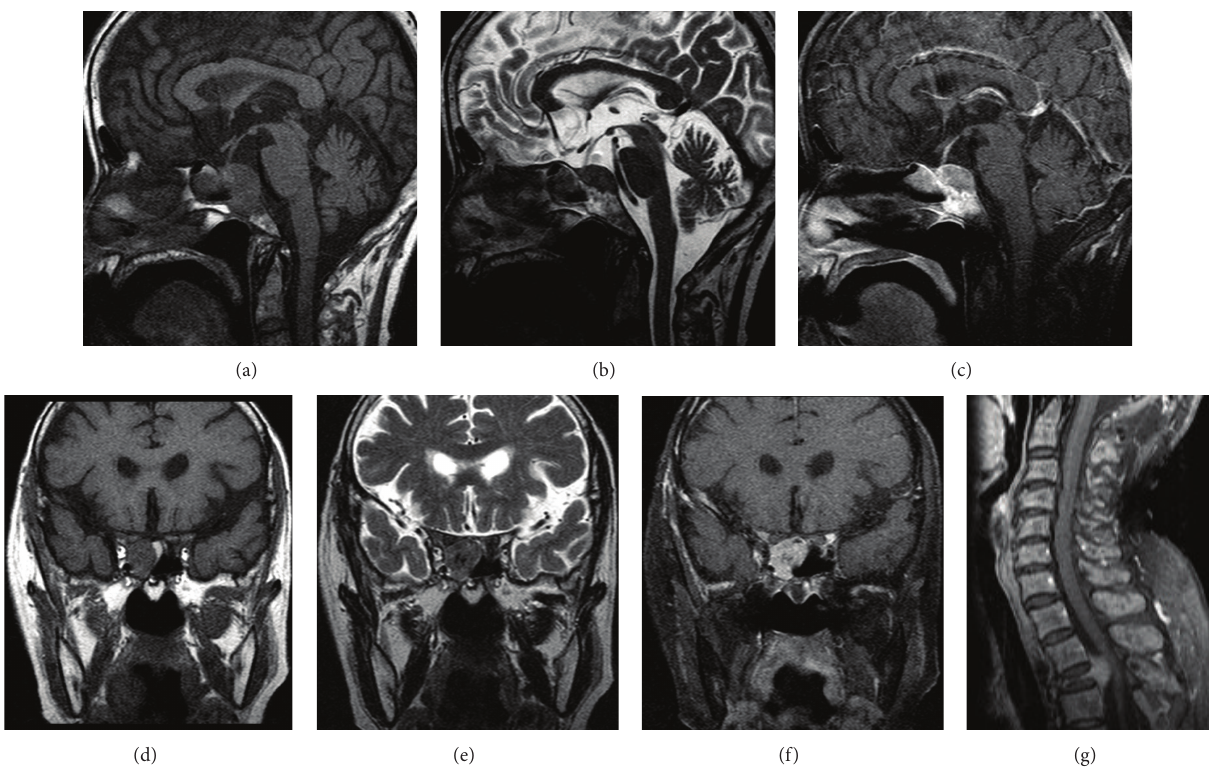
Figure 1: (a)–(f): Sagittal and coronal T1- ((a), (d)), T2- ((b), (e)), and Gd-enhanced T1-weighted ((c), (f)) MRI of the brain show a parasellar mass lesion. The lesion is isointense on T1-weighted images, iso- to hypointense on T2-weighted images, and inhomogeneously enhanced after contrast injection. (g) Sagittal Gd-enhanced thoracic MRI ( lower right ) shows a mass lesion with compression fracture of the Th3 vertebral